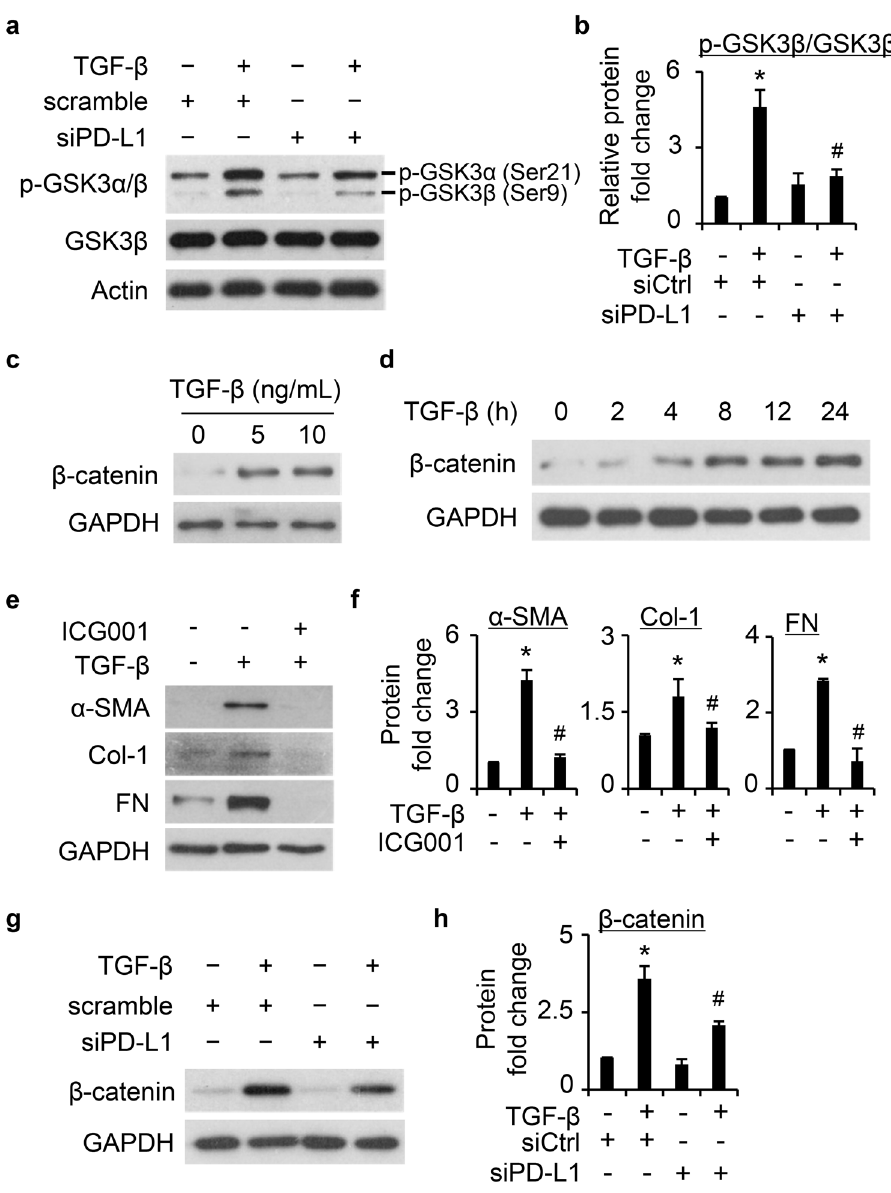
Figure 7. PD-L1 contributes to TGF-β-induced FMT involving the GSK3β/β-catenin pathway. ( a ), TGF-β (5 ng/mL, 24 h) induced phosphorylation of GSK3β (Ser9) and knockdown of PD-L1 using siRNA (siPD-L1) significantly attenuated GSK3β phosphorylation. ( b ), Quantification of a based on three independent experiments. ( c ), TGF-β induced β-catenin expression at 5 and 10 ng/mL in primary normal HLFs. ( d ), TGF-β (5 ng/mL) induced β-catenin expression in a time dependent manner in normal primary HLFs. ( e ), Pretreatment with the β-catenin inhibitor ICG001 (10 µM) for 30 min significantly blocked TGF-β (5 ng/mL) induced FMT marker expression. ( f ), Quantification of the data illustrated in ( e ) based on three independent experiments. ( g ), Knockdown of PD-L1 significantly attenuated TGF-β (5 ng/mL, 24 h) induced β-catenin expression. ( h ), Quantification of g based on three independent experiments. *, P < 0.05 vs. control group. #, P < 0.05 vs. TGF-β-treated scramble control